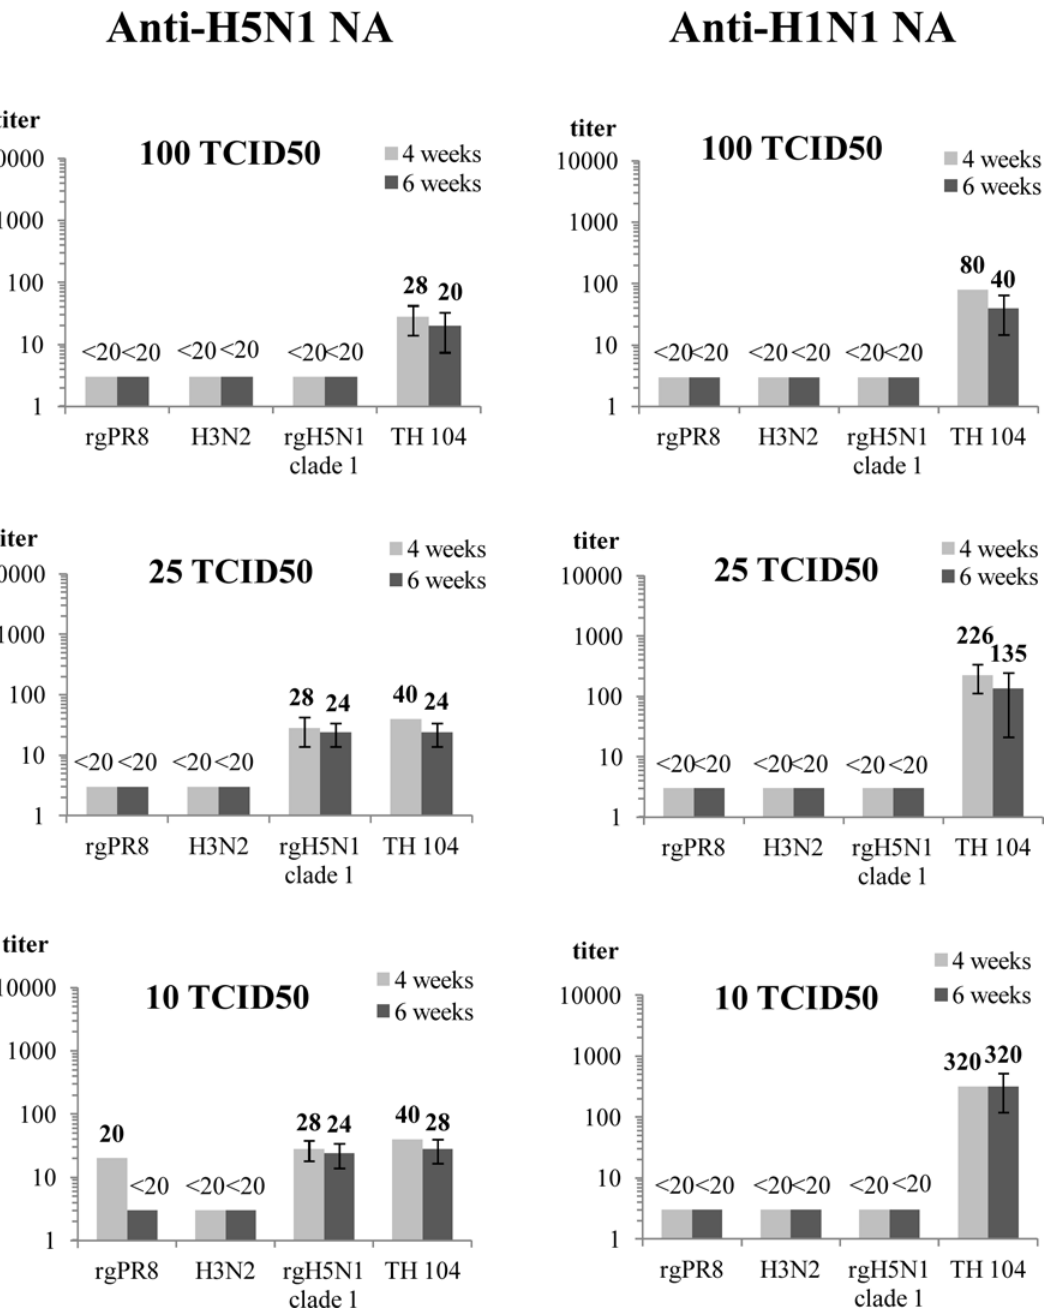
Fig 9. Inhibitory effect of anti-NA antisera against 3 virus concentrations (100, 25, and 10 TCID50) as determined by virus replication inhibition assay. Anti-H5N1 NA antisera modestly inhibit replication of reverse genetic (rg) virus carrying homologous NA and show moderate level of antibody titers that cross inhibit the H1N1pdm virus. On the other hand, anti-H1N1 NA antisera well inhibit replication of the H1N1pdm virus, but not cross inhibit rgH5N1 virus. Both kinds of anti-NA antisera do not inhibit rgPR8 virus and H3N2 virus. No significant difference in anti-NA antibody titers is found between pooled mouse sera collected at 4 weeks and 6 weeks p.i. (Mann-Whitney U test, p > 0.05). The geometric mean antibody titers are calculated. The error bars indicate standard deviations of 2 independent experiments for each lot of the test